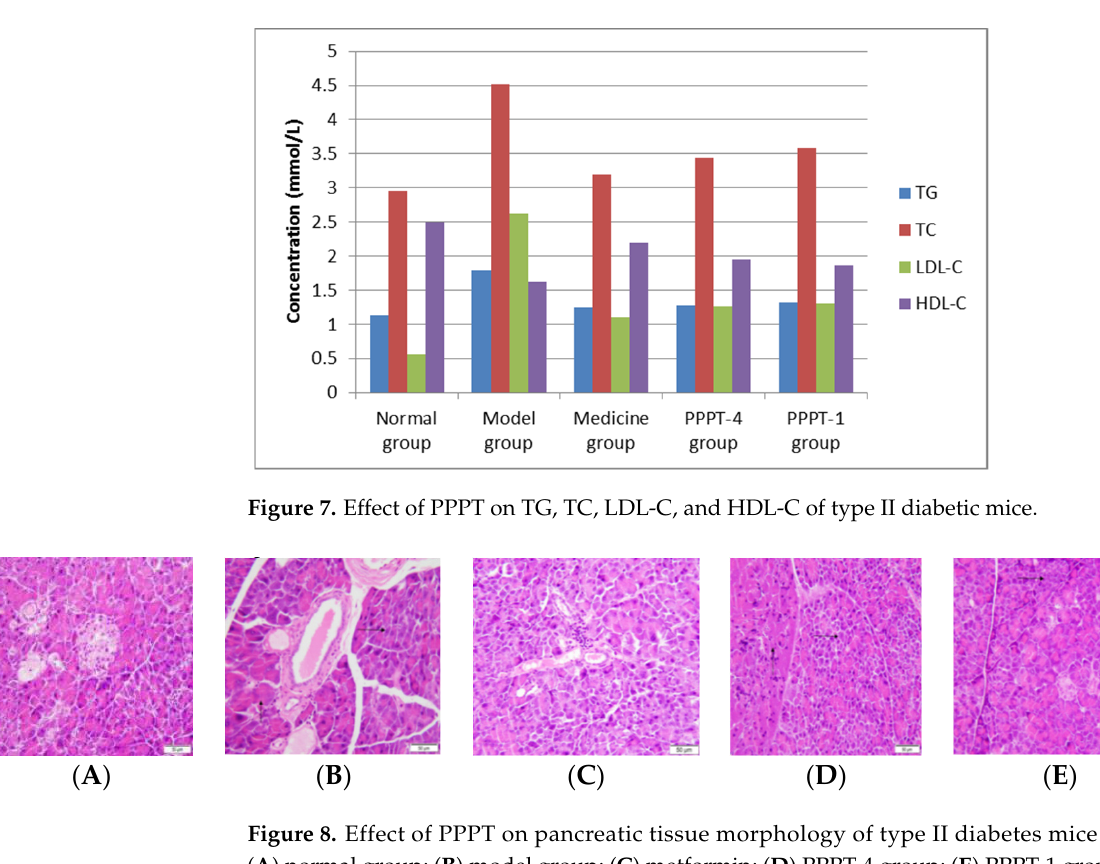
Figure 7. Effect of PPPT on TG, TC, LDL-C, and HDL-C of type II diabetic mice.